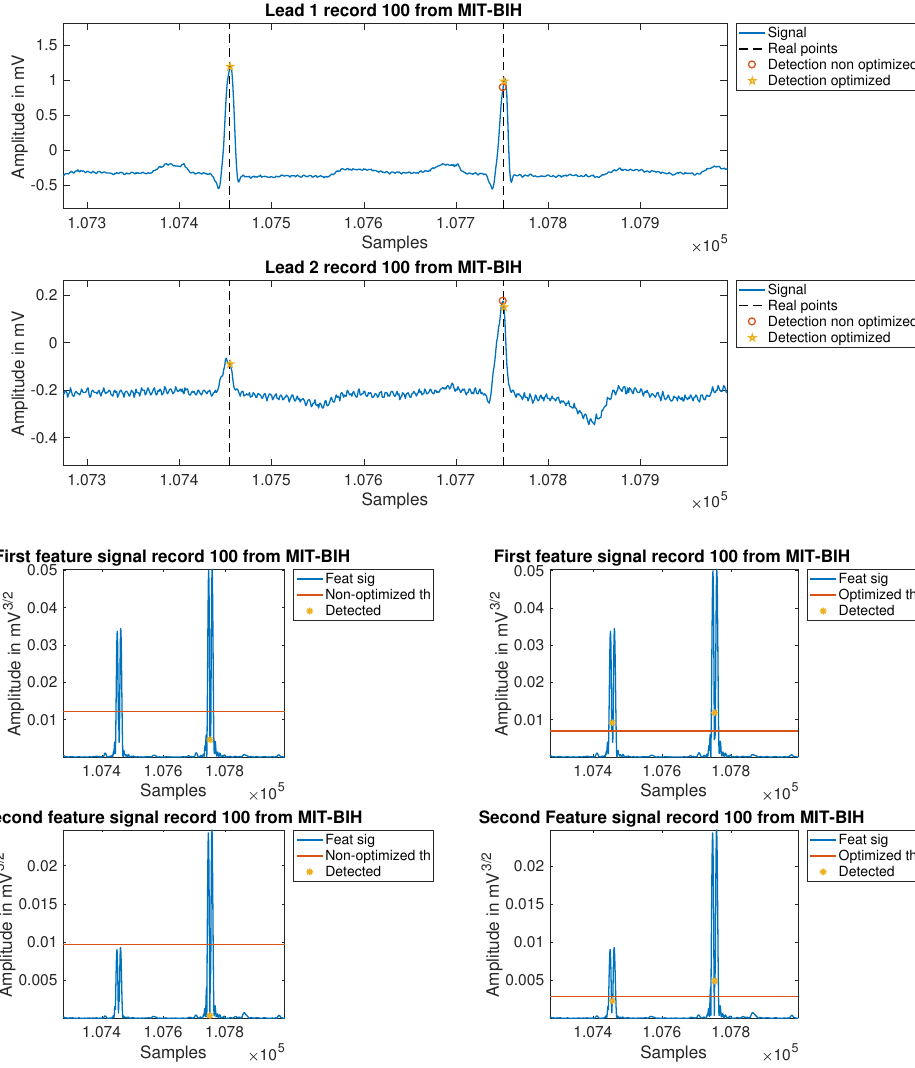
Figure 7. Comparison between the non-optimized and the optimized algorithm in record 100. The two upper panels depict leads 1 and 2. The four lower panels depict the feature signals for both